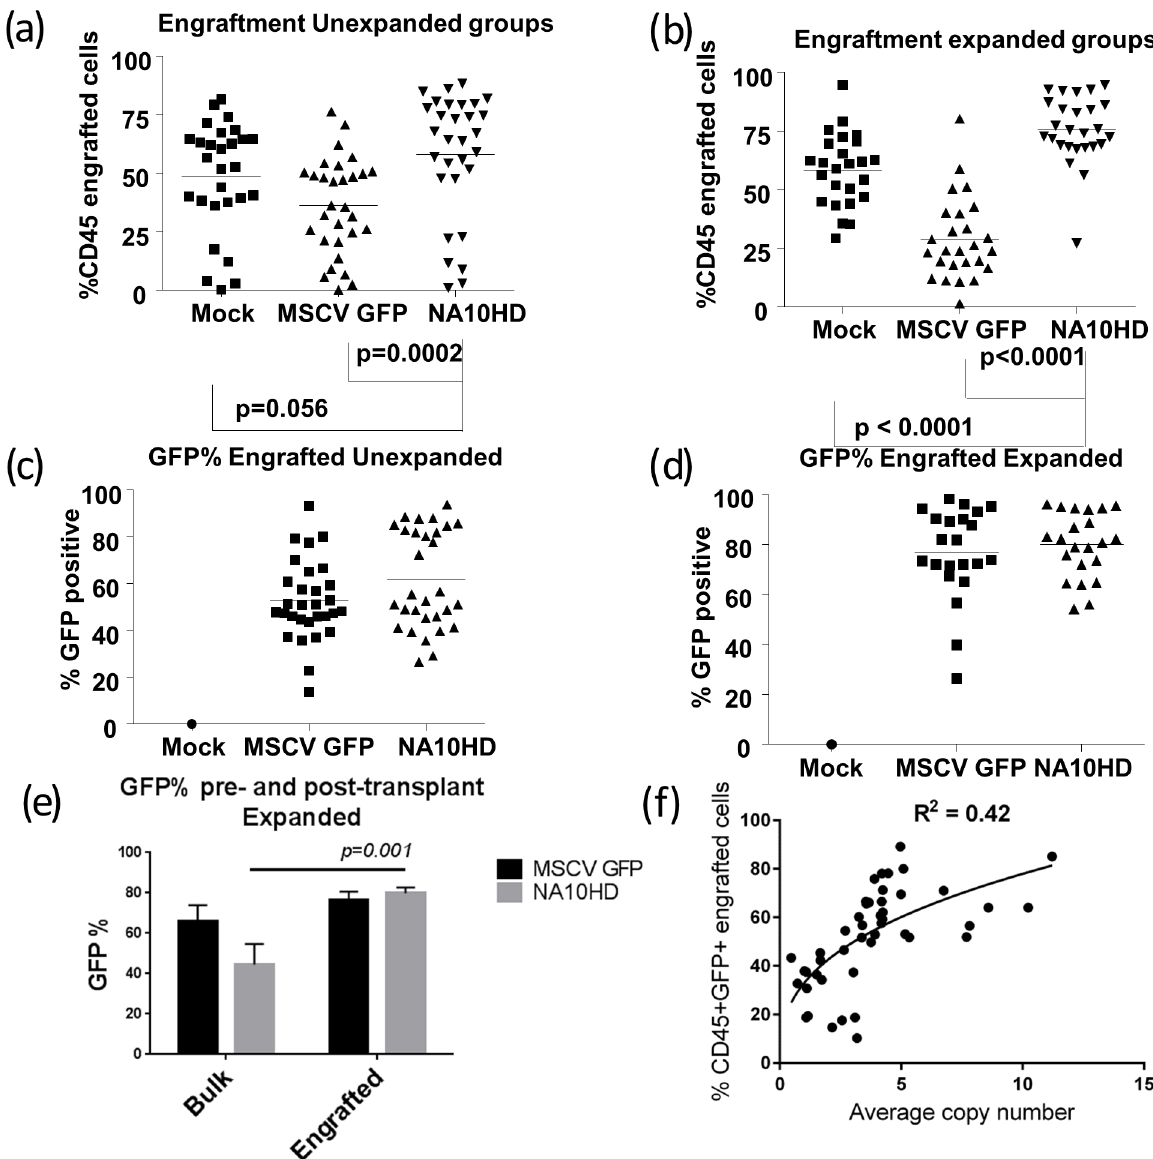
Fig 5. NUP98-HOXA10HD results in increased engraftment of CD45+ cells (a) and (b) – Human nucleated hematopoietic cell engraftment (CD45+) as percentage of total bone marrow harvested from NSG mice 12 – 15 week post transplantation with lentiviral transduced CD34+ cells. (a) represents transplantation 24 hours post transduction, (b) represents cells “ expanded ” in culture 1 week post transduction prior to transplant both showing NA10HD groups with significantly higher engraftment that MSCVGFP control, (c) and (d) – corresponding GFP expression of CD45+ cells. (e) Change in GFP% from input CD34+ bulk cells to engrafted CD45+ cells for “ expanded ” groups showing a significant increase in the NA10HD but not MSCV GFP group (p = 0.001 and 0.29 respectively, 2-tailed upaired t-test), (f) Average vector copy number per cell analysis of NA10HD vector as determined by qPCR shows a weakly positive correlation with engrafting transduced cells (CD45+GFP+) up to a copy number of approximately 5 and then plateaus, suggesting that the expansive effect of NA10HD increases with higher expression per engrafted cell but the effect has a ceiling. For (a)-(d), a p-value of 0.05 was considered significant, comparisons were performed using Mann-Whitney U